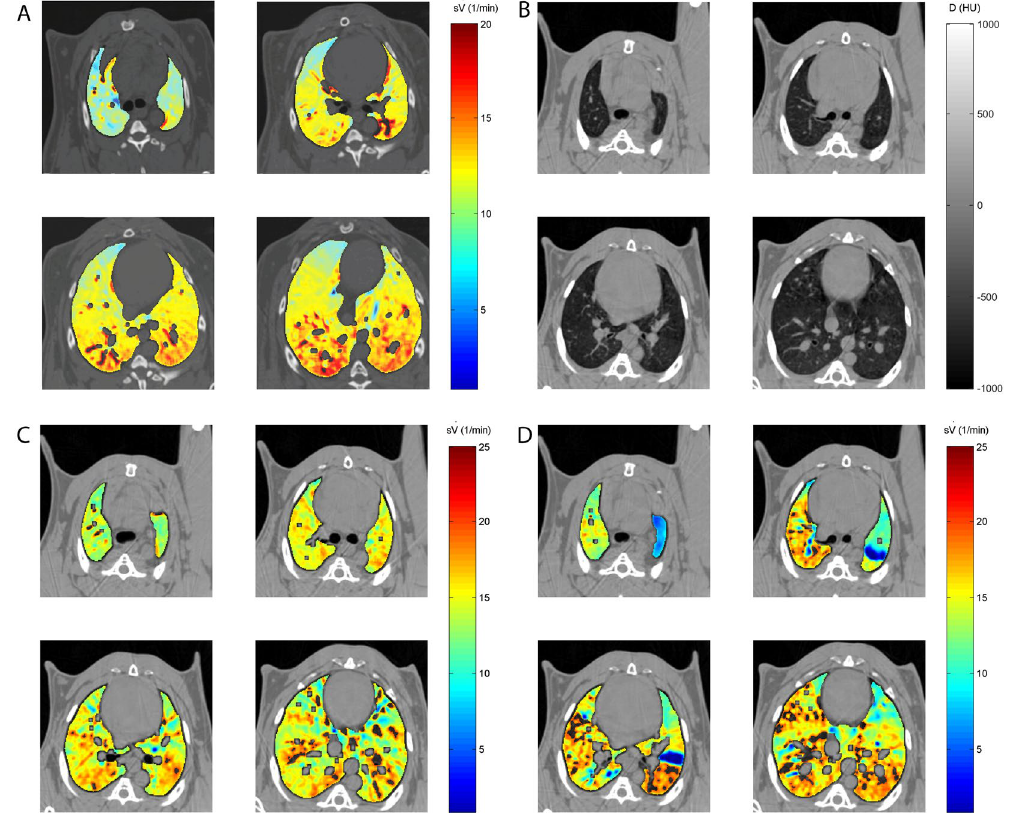
Figure 1. KES CT images of specific lung ventilation (  V s ), in one representative control rabbit ( A ); lung morphology ( B ) and  V s images in a MCH-challenged animal at baseline ( C ) and during the challenge ( D ). Note the constriction of central conducting airways and small peripheral ventilation inhomogeneities during MCH infusion.